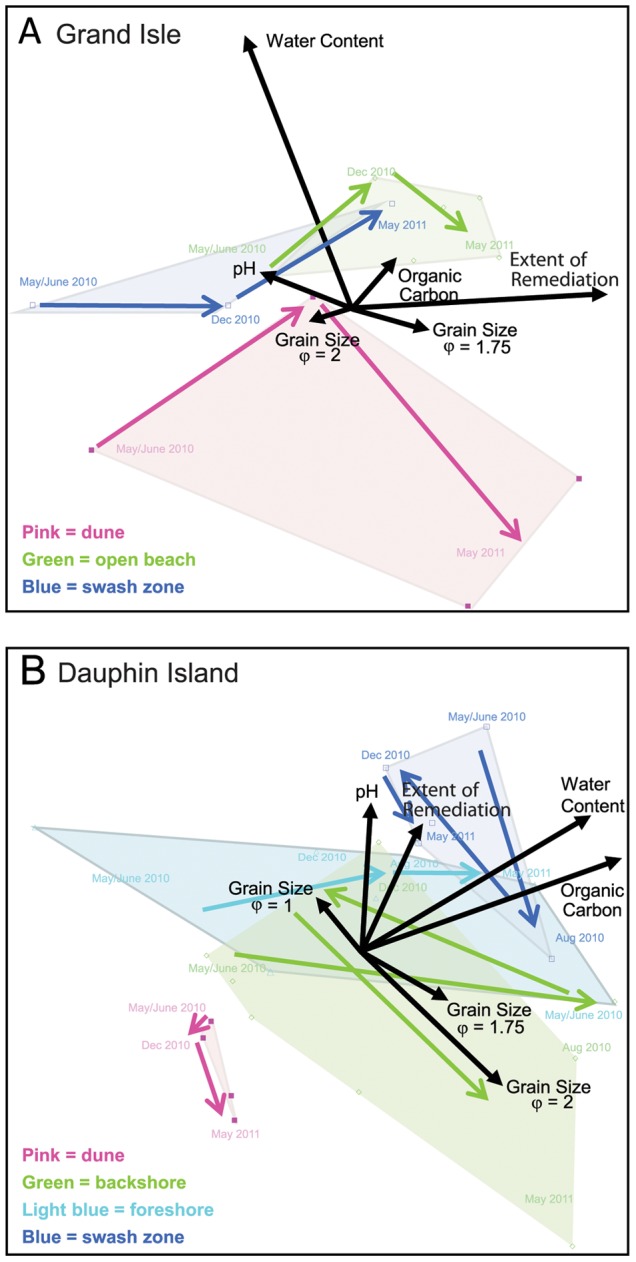
Non-metric multidimensional scaling (NMDS) plots based on microbial community compositions for all beach sand.(A) Grand Isle and (B) Dauphin Island community compositions from 16S rRNA gene pyrosequences that correspond to environmental variables and the extent of physical remediation at the beaches, shown as vectors. For (A), stress = 0.11, axis 1 R2 = 0.61 and axis 2 = 0.35. For (B), stress = 0.16, axis 1 R2 = 064 and axis 2 = 0.23. Colored arrows indicate the temporal shifts in community ordination for the dune, open beach areas, and swash zone.